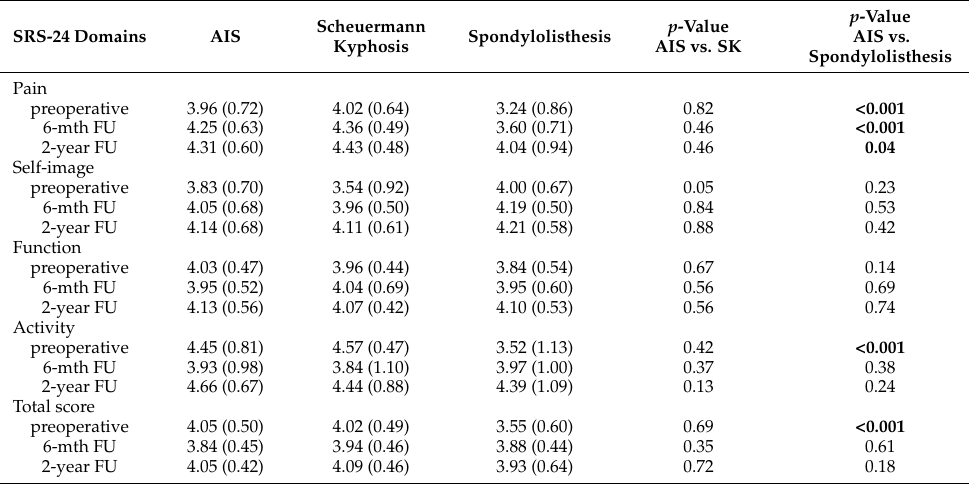
Table 2. SRS-24 domain scores in the